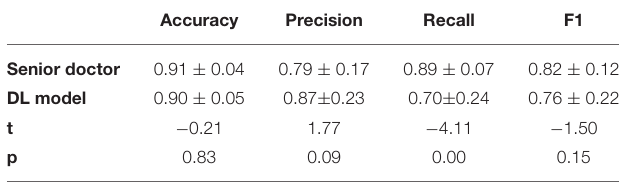
TABLE 4 | Evaluation indicators obtained by a 5-fold cross-validation. ID Accuracy Precision Recall F1 AUC